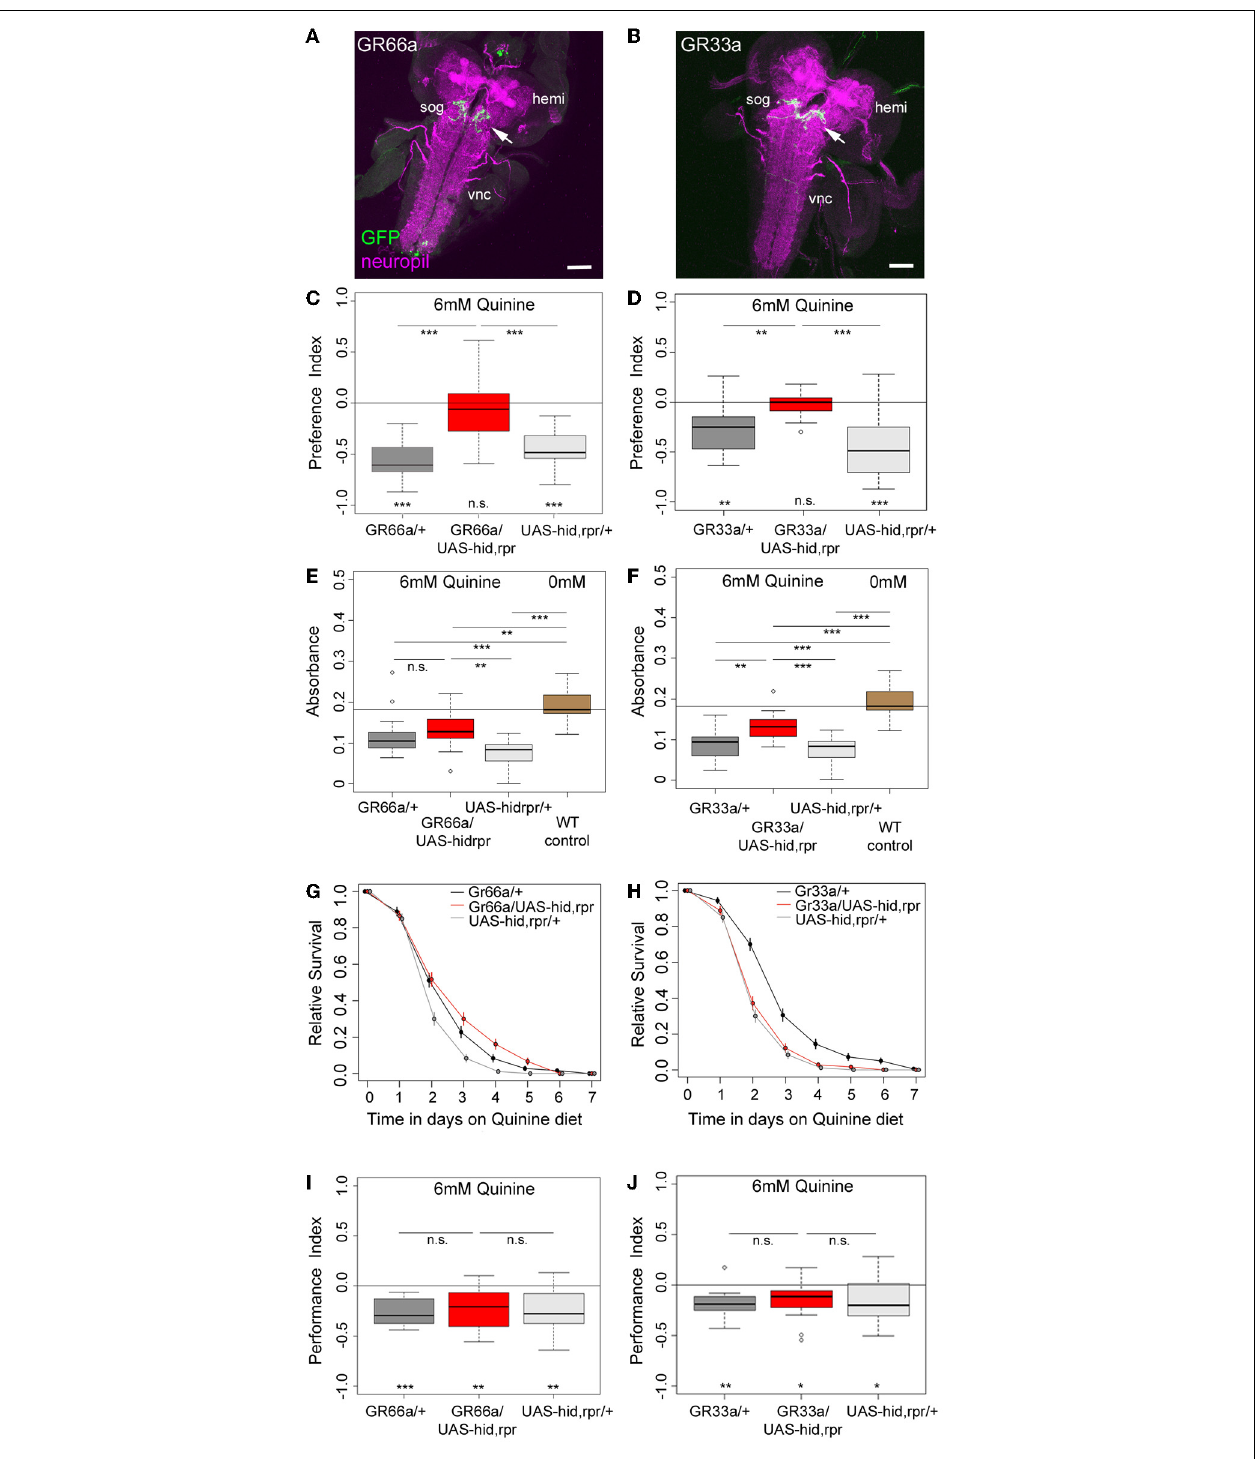
FIGURE 2 | GR66a and GR33a neuronal signaling is required for quinine-dependent choice behavior and feeding, but dispensable for survival and associative olfactory learning. (A,B) Show frontal views of CNS projections of GR66a-GAL4 and GR33a-GAL4 lines crossed with UAS-mCD8::GFP. To visualize the expression patterns, the CNS was stained with anti-GFP (green) and anti-ChAT; anti-FasII (magenta). In both lines, GRNs innervate the SOG in a similar way (arrows); sog, subesophageal